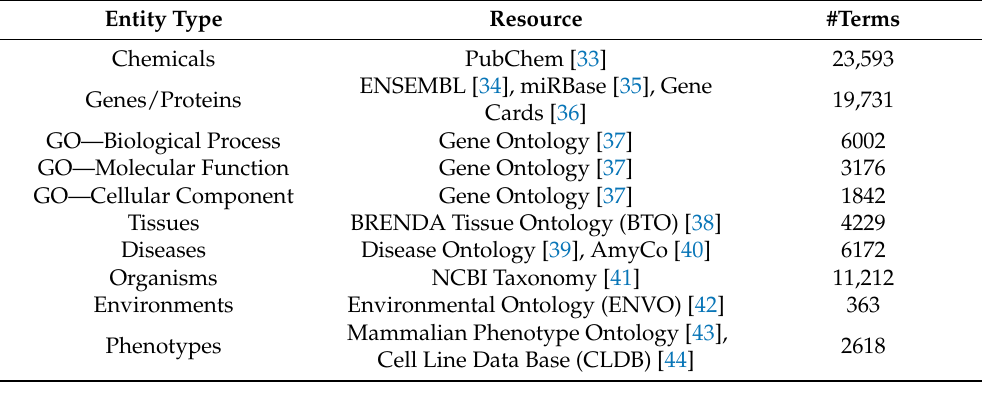
Table 1. Identified biomedical terms in a set of 881,185 articles mentioned in OMIM, HPO and DisGeNET databases.